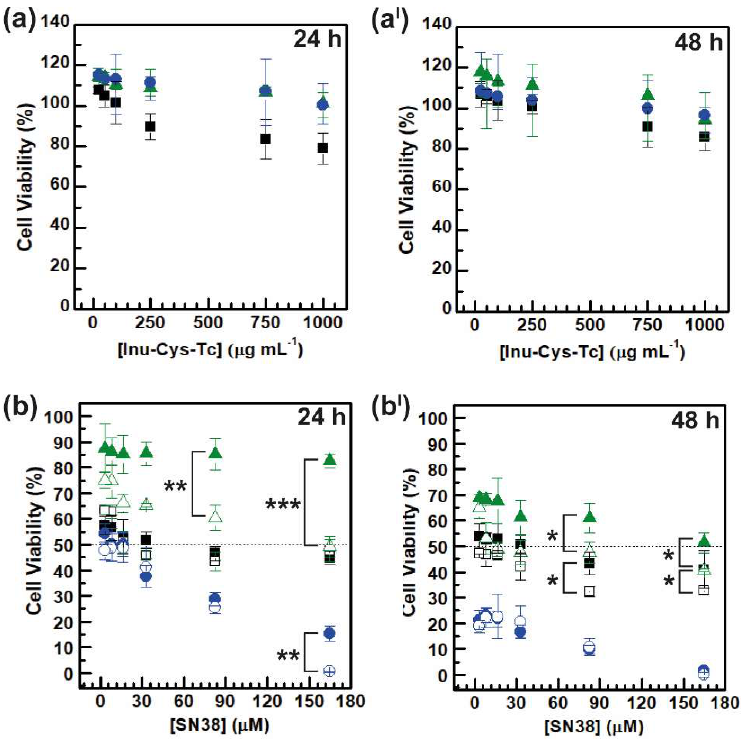
Figure 8. Study of the cytocompatibility of INU-Cys-TC ( a–a’ ) and INU-Cys-TC@SN38 ( b–b’ ) after 24 h ( a–b ) and 48 h ( a’–b’ ) of incubation on MCF-7 (black), HCT-116 (blue), and 16-HBE (green). Full symbols correspond to INU-Cys-TC ( a–a’ ) and INU-Cys-TC@SN38 ( b–b’ ), while empty symbol correspond to free SN38 ( b–b’ ). p < 0.05 (*), p < 0.01 (**), and p < 0.001 (***)